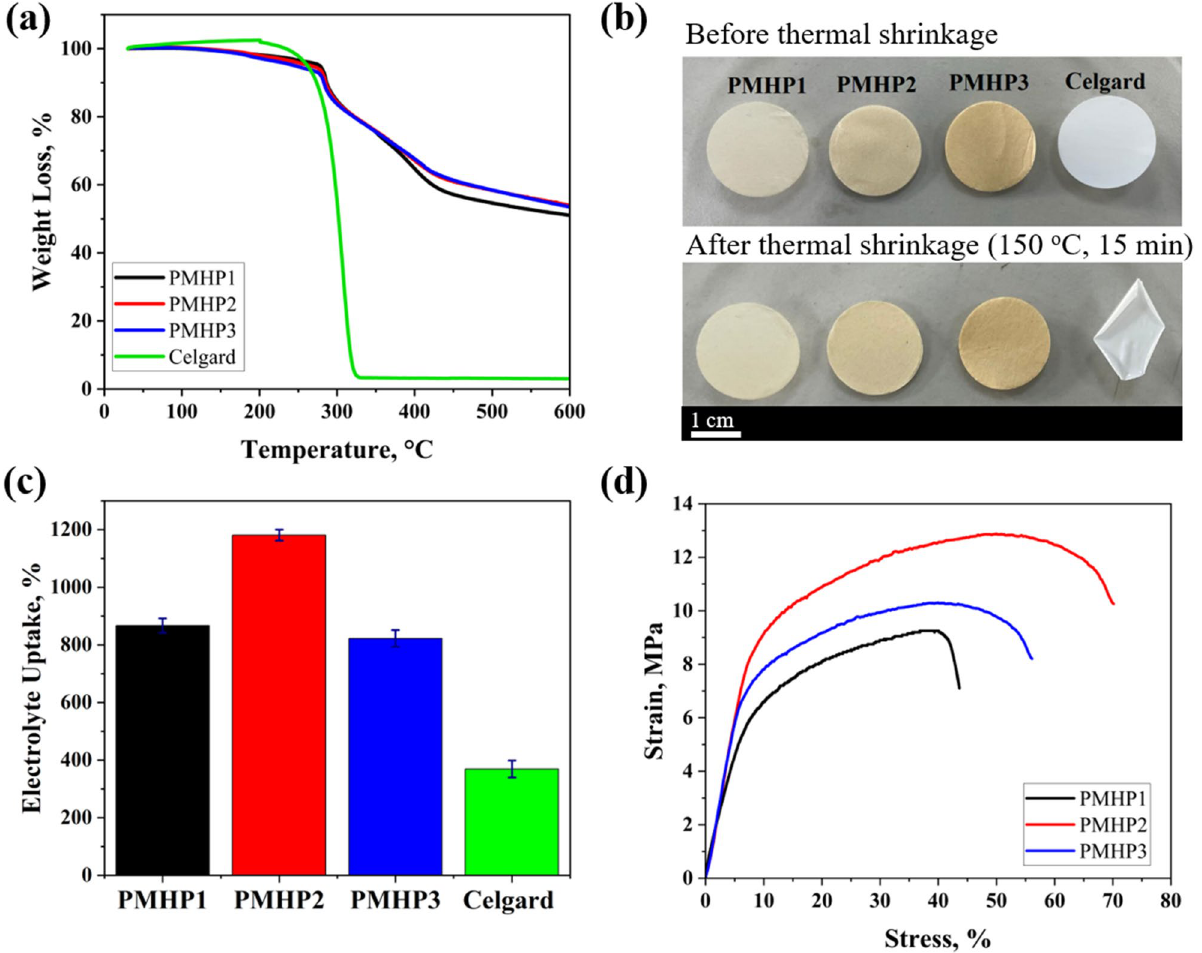
Figure 5. ( a ) Thermo-gravimetric analysis, ( b ) thermal exposure test photos before and after thermal treatment at 150 °C for 15 min, ( c ) liquid electrolyte uptake chart, and ( d ) typical stress–strain curves of PMHP1, PMHP2, PMHP3, and Celgard-2400